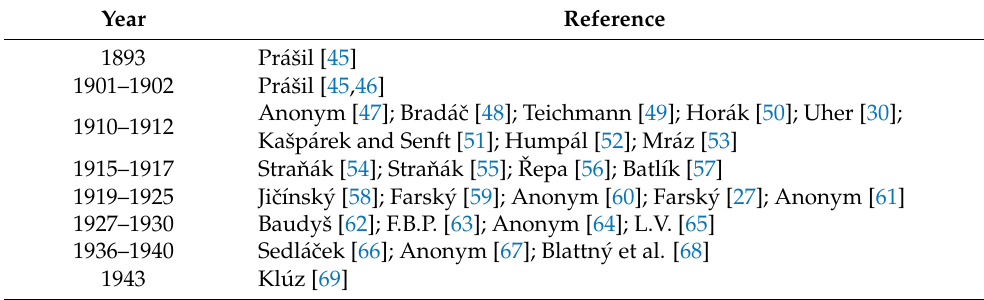
Table 2. Literature documenting population outbreaks in the first half of the 20th century in the Czech